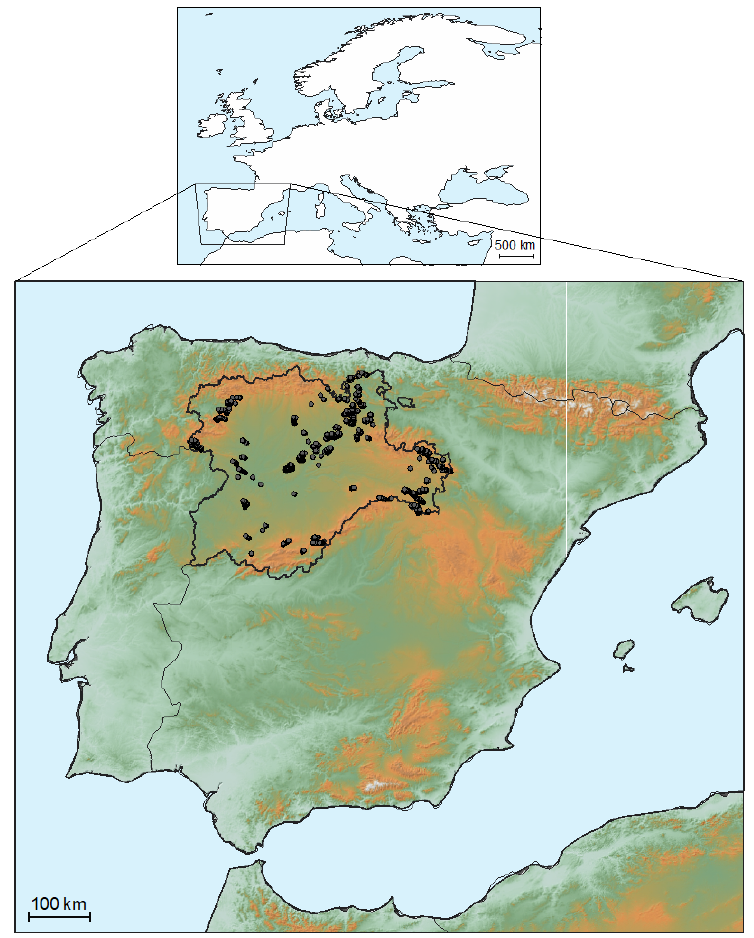
Figure 1. Zoom-in to the Iberian Peninsula showing the country borders and the administrative division Castilla y león (Spain) in the center of the region. The dots represent the indicative distribution of wind turbines (4291) installed at the end of this study. The map was generated using QGIS 3.16 in WGS 84 reference system ( top ) and ETRS89/UTM zone 30N projection ( bottom ).